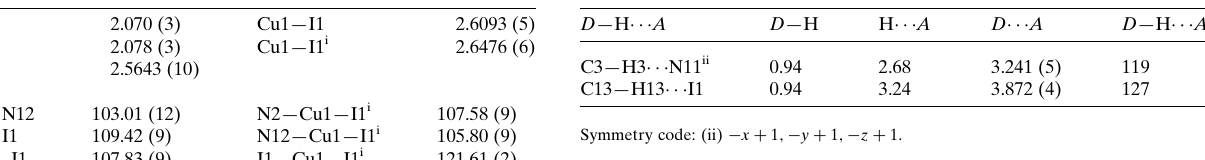
Table 1 Selected geometric parameters (A˚ , (cid:5)